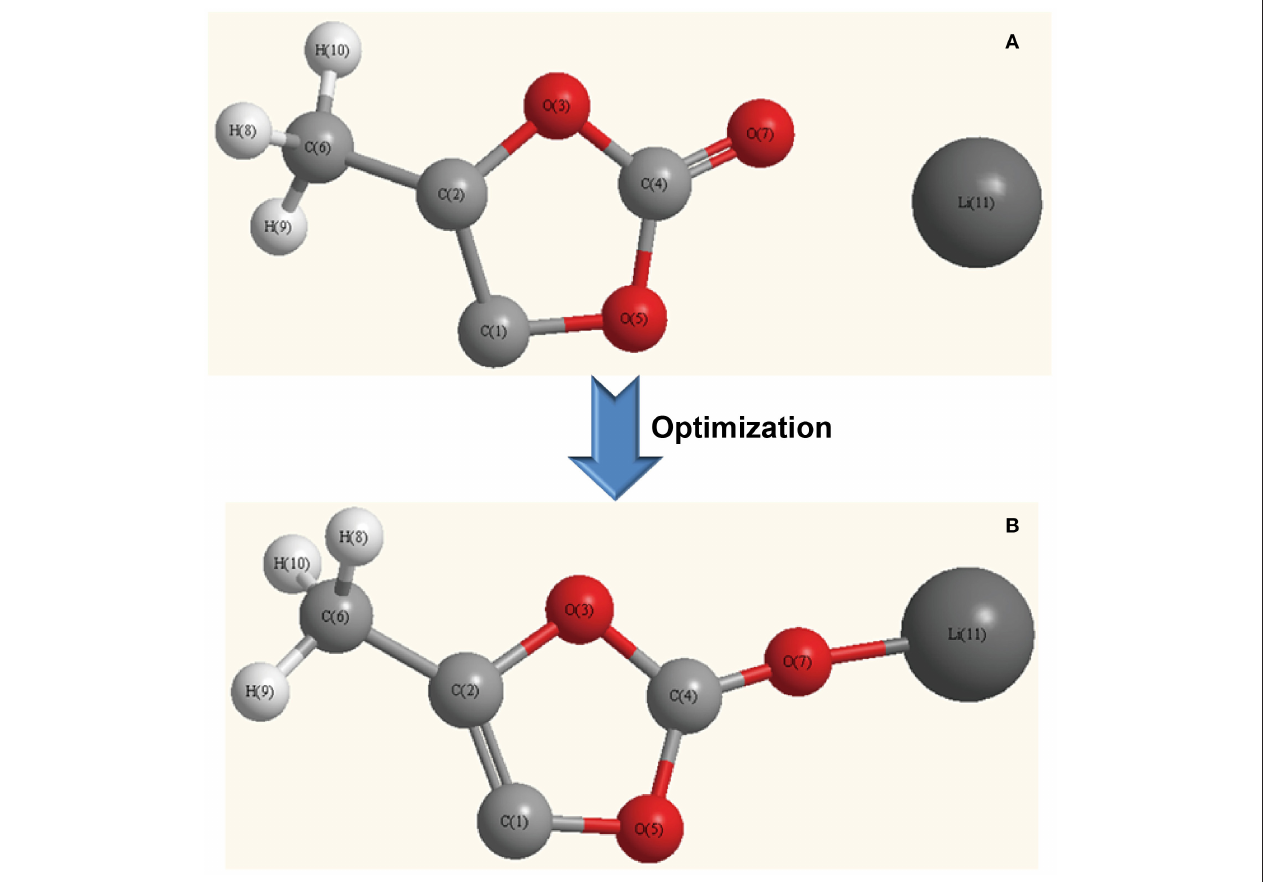
FIGURE 4 | Li-PC complex configurations (A) before and (B) after optimization through chemical simulation